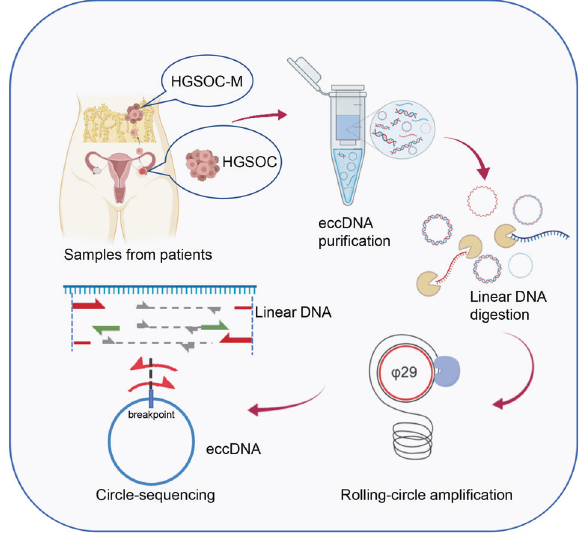
Fig. 1 A schematic to illustrate Circ-Seq. Paired primary tissues (HGSOC 1-4) and metastatic tissues (HGSOC-M 1-4) of HGSOC were obtained from four HGSOC patients. EccDNAs were separated, puri fi ed and rolling-circle ampli fi ed for Circ-Seq. Detection of eccDNA was based on soft clipped reads (Red arrows, soft-clipped reads; Grey arrows, concordant reads; Green arrows, discordant